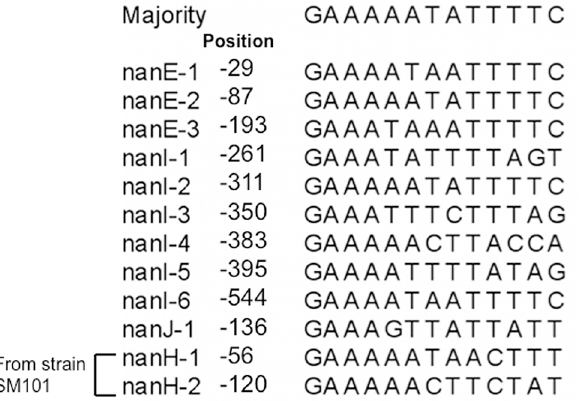
Fig 7. Alignment of conserved 14-bp elements located in the promoter regions of sialic acid-related genes. Majority refers to the consensus sequence calculated by the Megalign program (Lasergene, v. 11, DNASTAR). “ Position ” refers to the distance from the adenosine in the initiator methionine residue for each gene shown to the left. The numbers following each gene indicate the proximity of the sequence to the start codon with the sequences closest to the start represented by the lowest